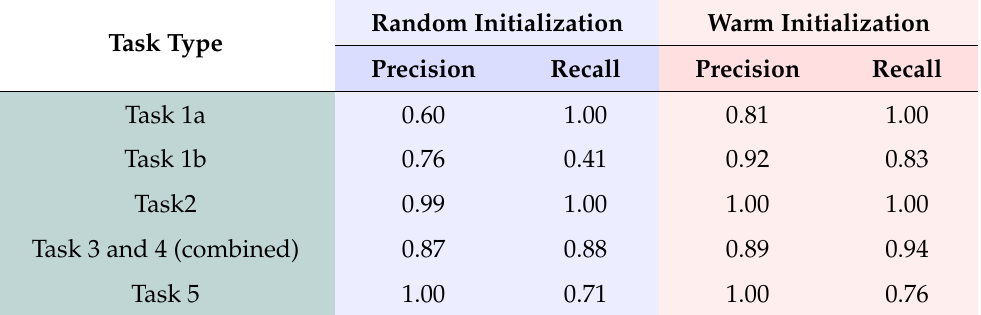
Table 7. The comparison of precision and recall of the trained model based on random initialization and warm initialization for Participant